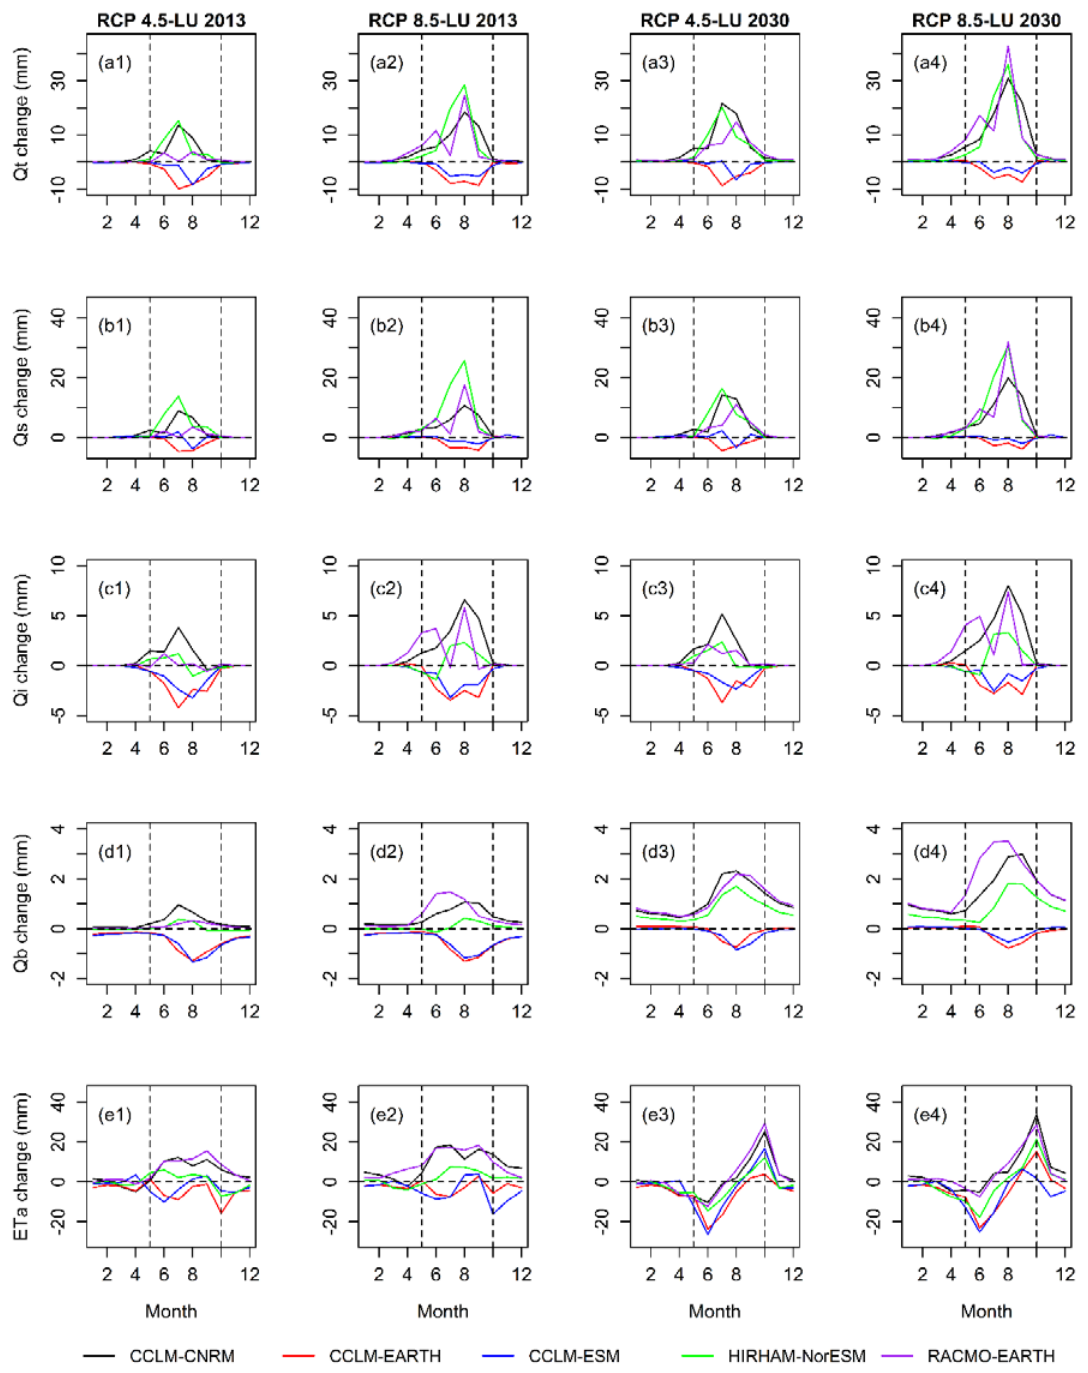
Figure 12. Monthly change of predicted (2021–2050) total runoff (Qt), surface runoff (Qs), interflow (Qi), base flow (Qb), and actual evapotranspiration (ETa) compared to the reference period (1971– 2000). RCP: representative concentration pathway; LU: land use. The vertical dashed lines show the beginning and end of the rainy season. ( a ): total runoff; ( b ): surface runoff; ( c ): interflow; ( d ): base flow; ( e ): actual evapotranspiration. ( 1 ): RCP 4.5-LU 2013; ( 2 ): RCP 8.5-LU 2013; ( 3 ): RCP 4.5-LU 2030; ( 4 ): RCP 8.5-LU 2030.